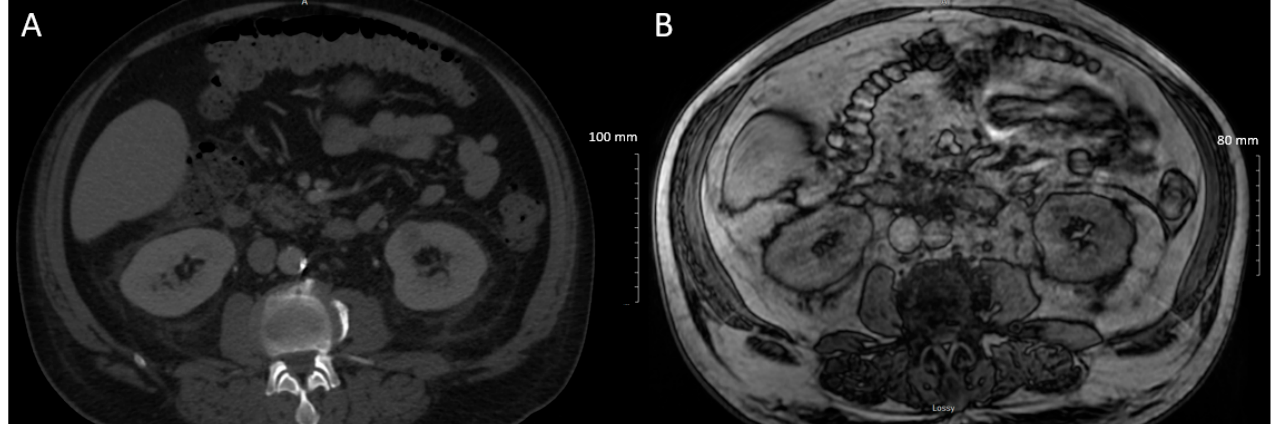
Figure 2. ( A ) Axial CT revealing indeterminate 18 mm left renal lesion; ( B ) Axial dynamic gradient echo sequence demonstrating 17 mm T2 hypointense left renal lesion in keeping with renal cell